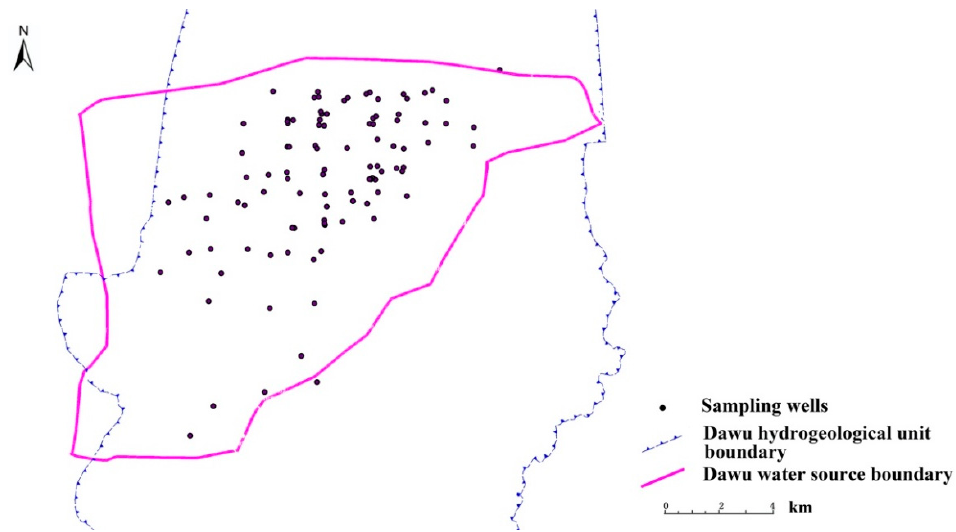
Figure 2. Map of the Dawu water source boundary with the locations of the sampling wells.